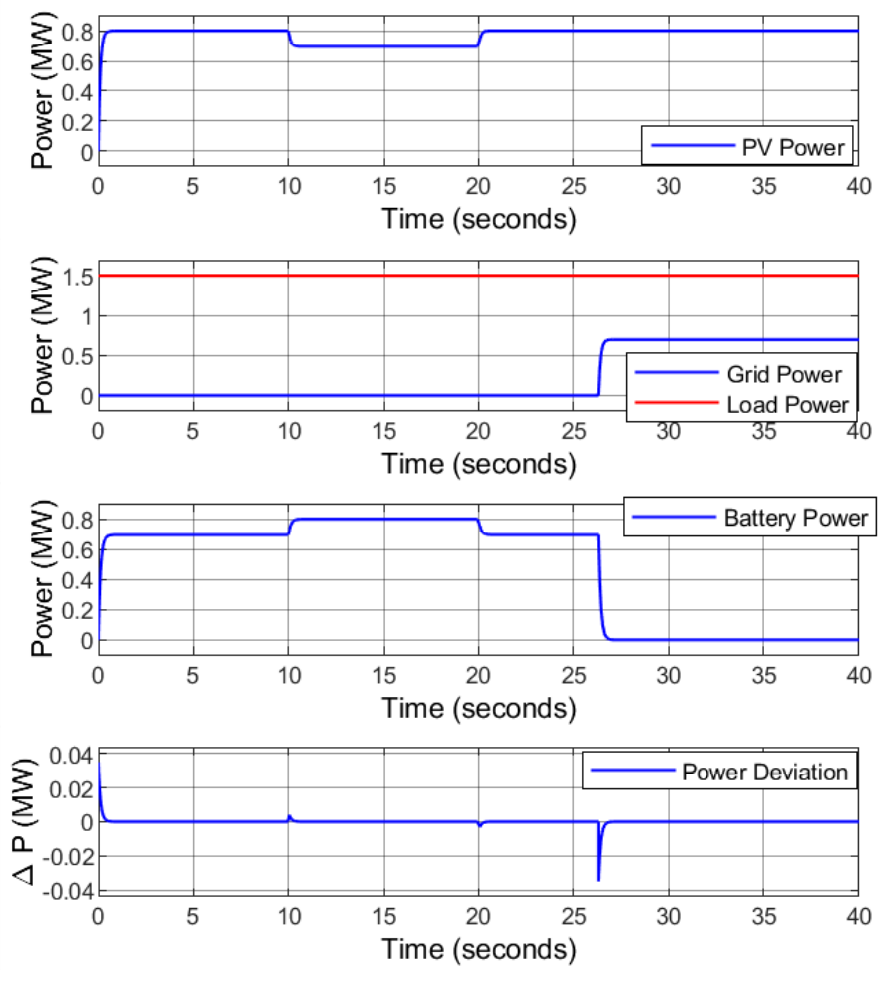
Figure 4. Scenario 1: power management of the microgrid.